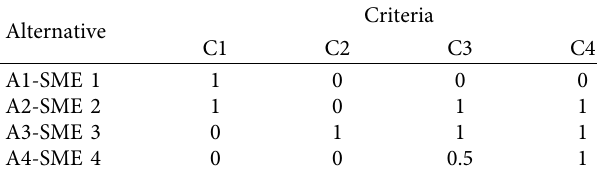
Table 12: Vector weight value ( w ) specification criteria.